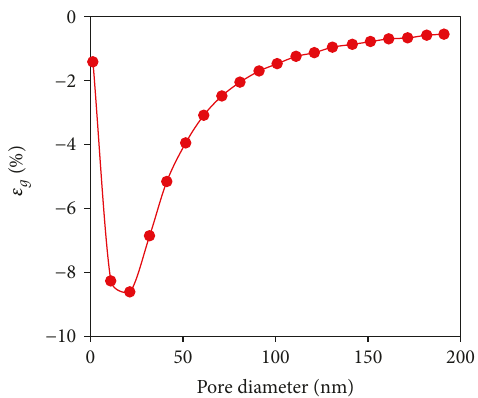
Figure 18: The e ff ect of gas density on total apparent permeability (20